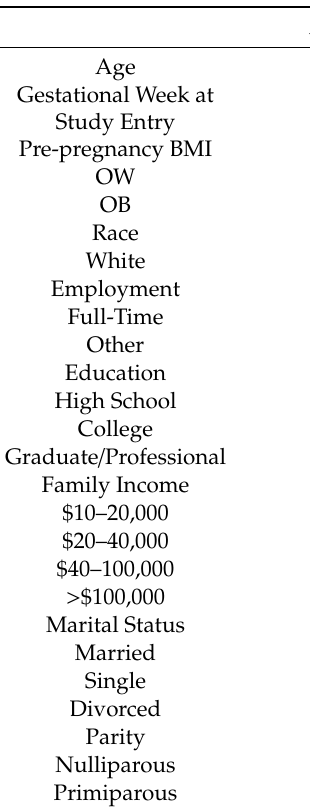
Table 1. Participant Characteristics ( N =